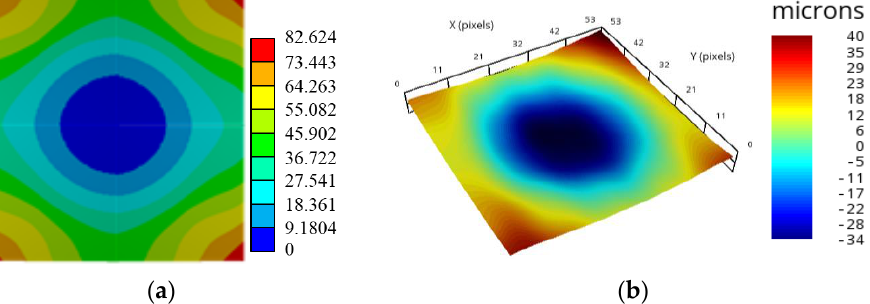
Figure 12. Warpage evolution: ( a ) from die bond to mold cure process; ( b ) during increasing temperature process.